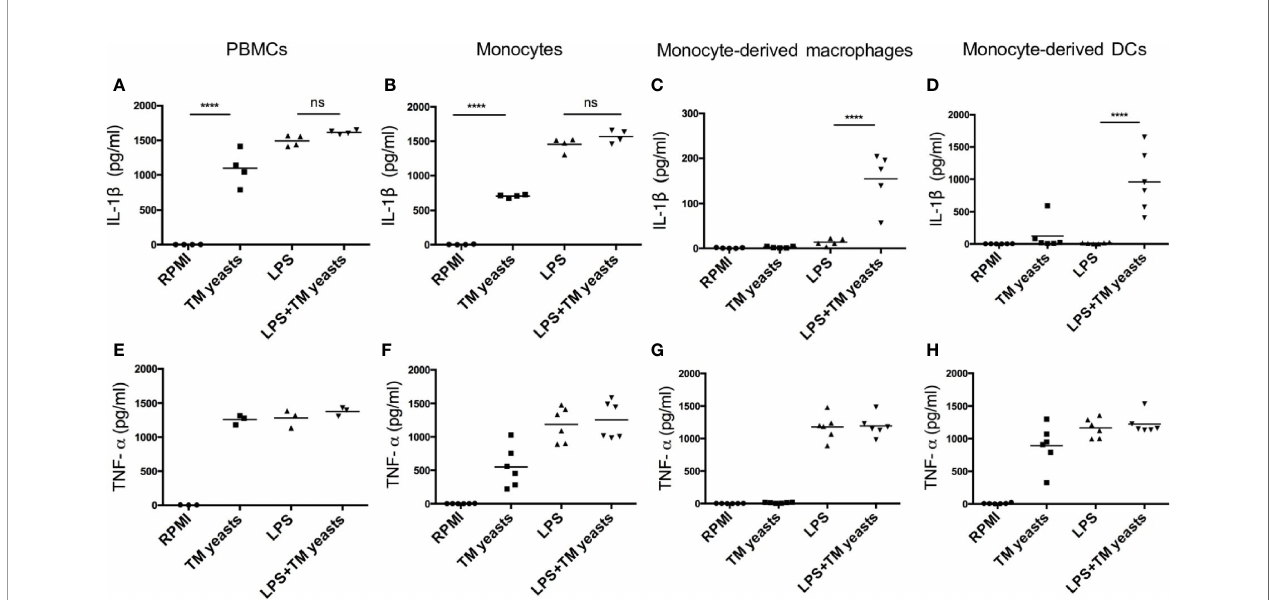
FIGURE 2 | Differential requirement for IL-1 b response to T. marneffei yeasts in various human immune cell types. (A ‒ D) Quantitative ELISA detection of IL-1 b in human PBMCs (4x10 6 /ml), CD14 + monocytes (2x10 6 /ml), human monocytes-derived macrophages (1x10 6 /ml), CD14 + monocytes-derived dendritic cells (DCs) (1x10 6 /ml), respectively, after stimulation with heat-killed T. marneffei (TM) yeasts (0.5 MOI) for 18 hr with or without LPS priming. (E ‒ H) Quanti fi cation of TNF- a by ELISA in human PBMCs (4x10 6 /ml), CD14 + monocytes (2x10 6 /ml), human monocytes-derived macrophages (1x10 6 /ml), CD14 + monocytes-derived dendritic cells (DCs) (1x10 6 /ml), respectively, after stimulation with heat-killed T. marneffei (TM) yeasts (0.5 MOI) for 18 hr with or without LPS priming. Each symbol represents one healthy donor, and data are analyzed by one-way ANOVA. ns, not signi fi cant, ****p <